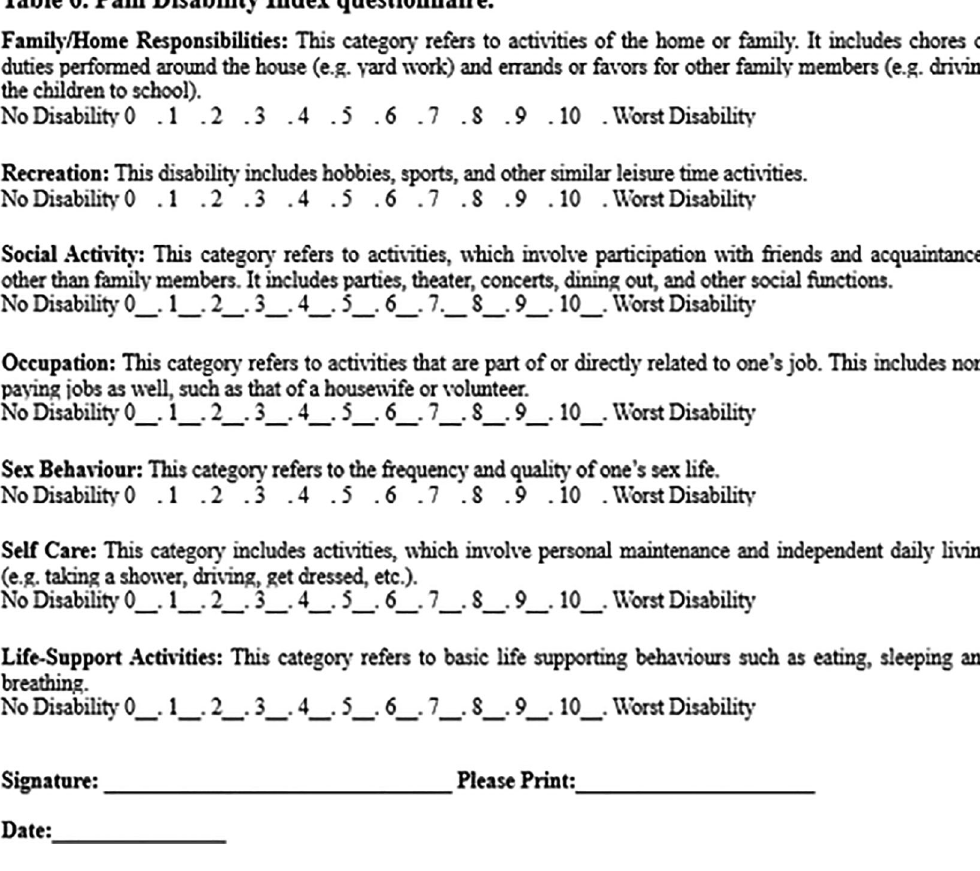
Figure 2. Pain Disability Index questionnaire. (Reproduced from Wang et al. ,